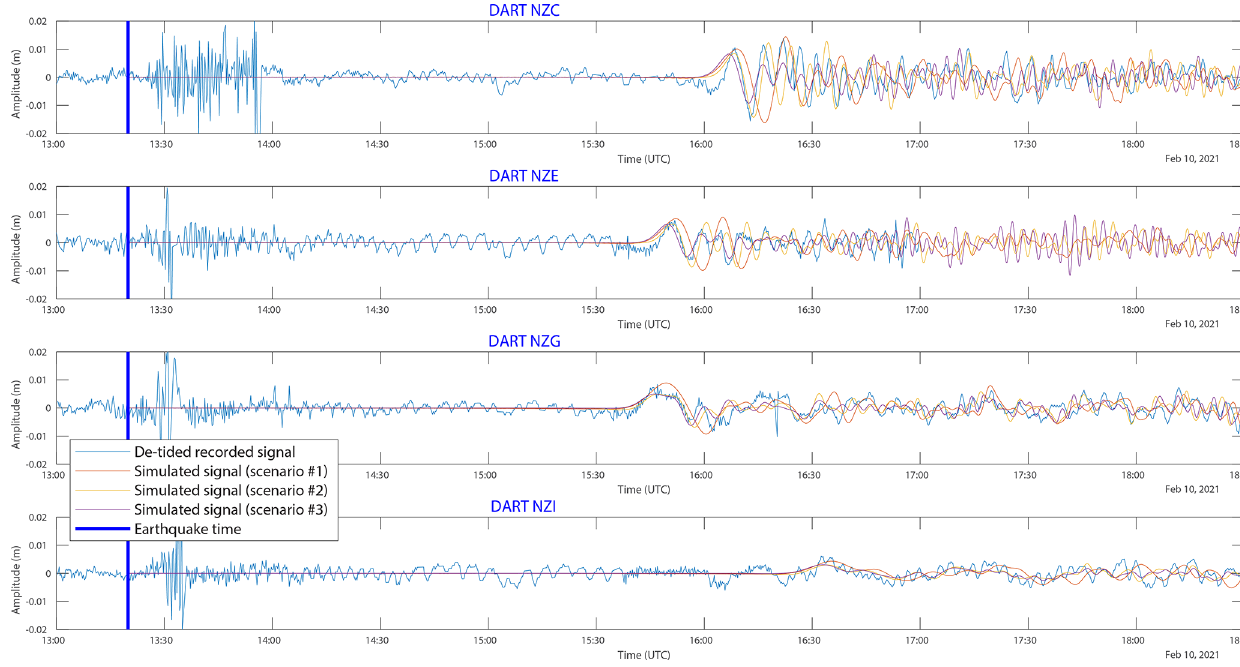
Figure 10. Sea level fluctuations associated with the 10 February 2021 earthquake and tsunami recorded by the New Zealand DART NZC, NZE, NZG, and NZI: blue lines represent the de-tided real recorded data, red lines represent the simulated signal for a M w 7.7 uniform slip model, yellow lines represent the simulated signal for a M w 7.7 non-uniform slip model obtained from inversion of tsunami waveforms (Gusman et al., 2022), and purple lines represent the simulated signal obtained with the USGS M w 7.7 non-uniform slip model. The blue vertical line symbolizes the earthquake